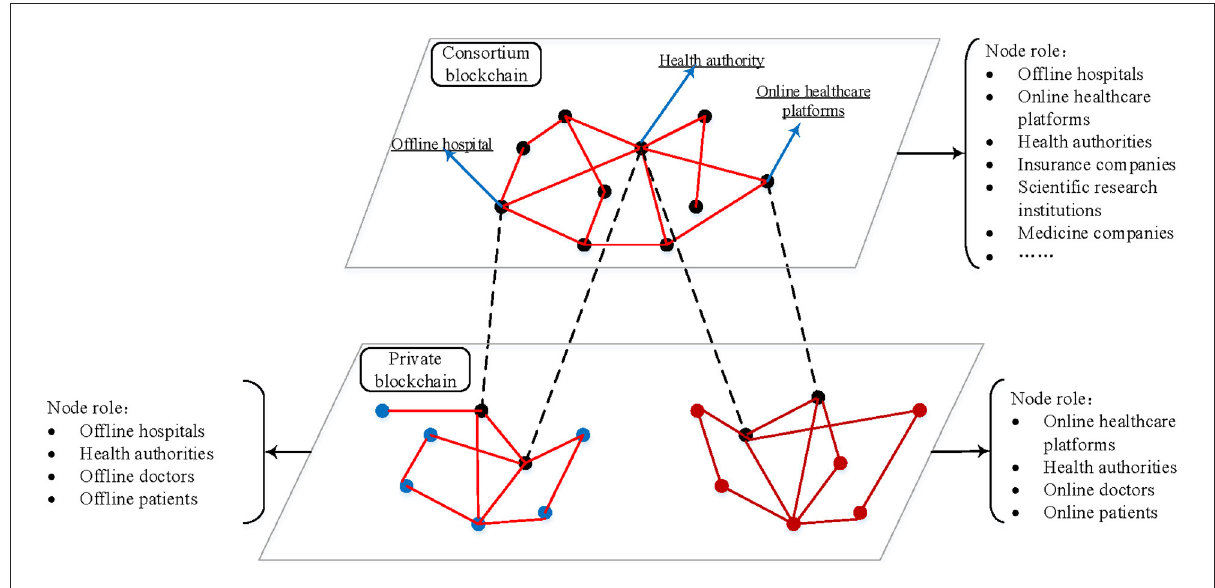
FIGURE2 The node network of the MBDS